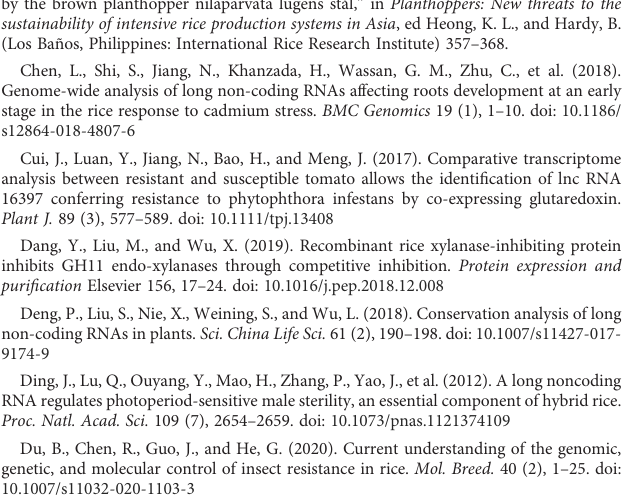
WRKY TFs identi fi ed in the